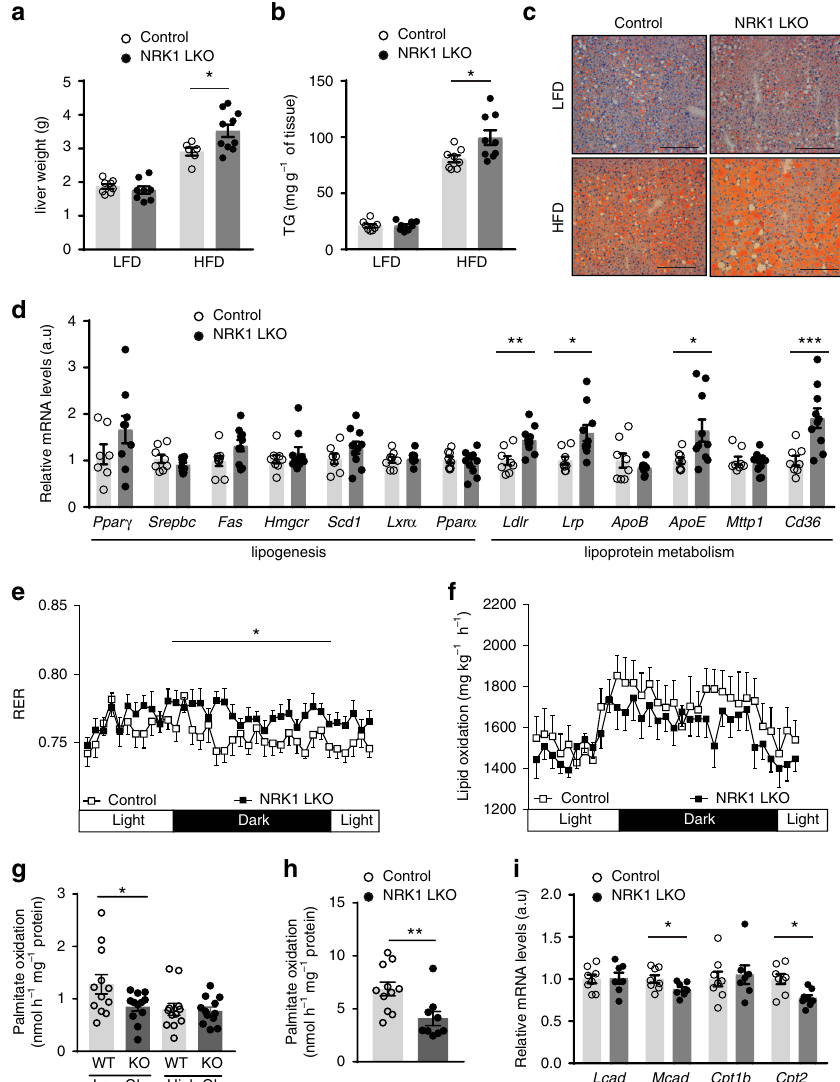
Fig. 3 NRK1 de fi ciency promotes hepatic steatosis by impairing fatty acid oxidation. a , b Liver weight a and triglycerides (TG) levels b in liver of NRK1 LKO and control mice on LFD and HFD ( n = 7 mice for the control group; n = 10 mice for the NRK1 LKO group; 24 weeks of age). c Oil-Red O staining of liver sections from NRK1 LKO and control mice on LFD and HFD (scale bars: 200 μ m). d mRNA level of genes involved in lipogenesis and lipoprotein metabolism in the liver of HFD-fed NRK1 LKO and control mice (n = 8 mice for the control group; n = 10 mice in the NRK1LKO group). e Respiratory exchange ratio (RER) in NRK1 LKO and control mice on HFD ( n = 9 mice for the control group; n = 10 mice for the NRK1LKO group). f Lipid oxidation of NRK1 LKO and control mice on HFD. Data calculated from indirect calorimetry measurements: lipid oxidation = (1.67 x VO 2 ) – (1.67 x VCO 2 ) 43 ( n = 9 mice for the control group; n = 10 mice for the NRK1 LKO group). g Fatty acid oxidation in primary hepatocytes isolated from 10 to 20 week-old WT and NRK1 KO mice. 3 H-Palmitate oxidation was measured in conditions of low and high glucose ( n = 12 for all groups). h Fatty acid oxidation in primary hepatocytes isolated from 8 to 12 week-old WT and NRK1 KO mice. 3 H-Palmitate oxidation was measured in condition of lipid overload. i . mRNA level of genes involved in β -oxidation in the liver of HFD-fed NRK1 LKO and control mice ( n = 8 for WT hepatocytes; n = 7 for KO hepatocytes). Results shown are mean ± SEM, *, **, and *** indicate statistical difference vs. respective control group at p < 0.05, p < 0.01 and p < 0.001, respectively. The individual values and statistical tests used for each panel can be found in the Source Data fi